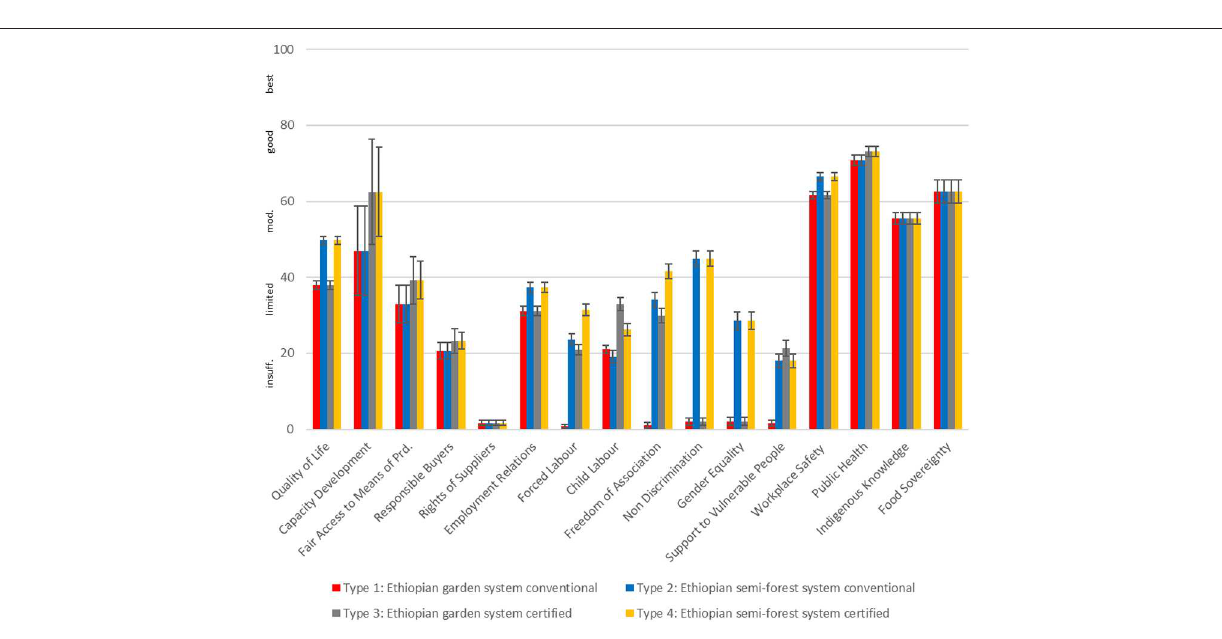
FIGURE 6 | Sustainability performance of typical Ethiopian coffee production systems for “Social